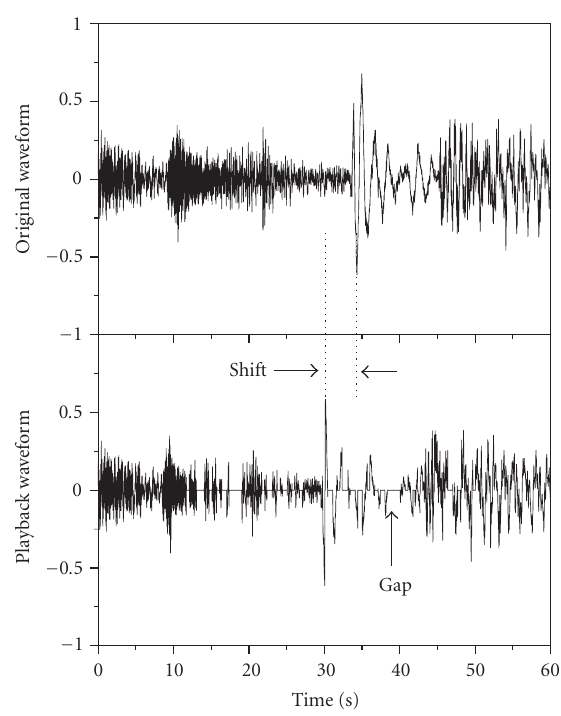
Figure 8: (a) Original digital audio source waveform, (b) repro- duced (playback)